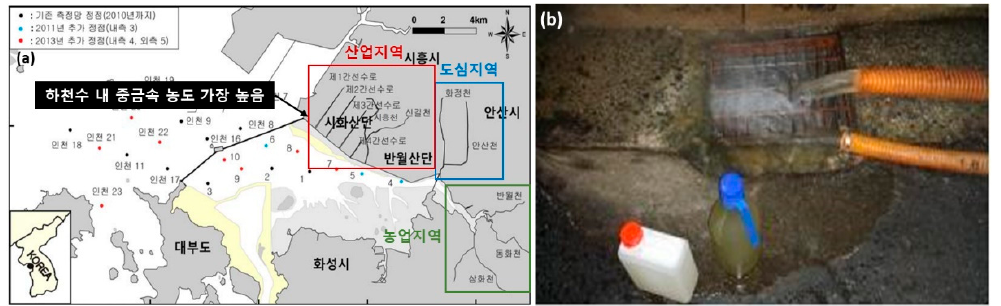
Figure 7. ( a ) Location of Banwol and Sihwa industrial site, and ( b ) Control site for unauthorized discharge of wastewater in industrial complexes.